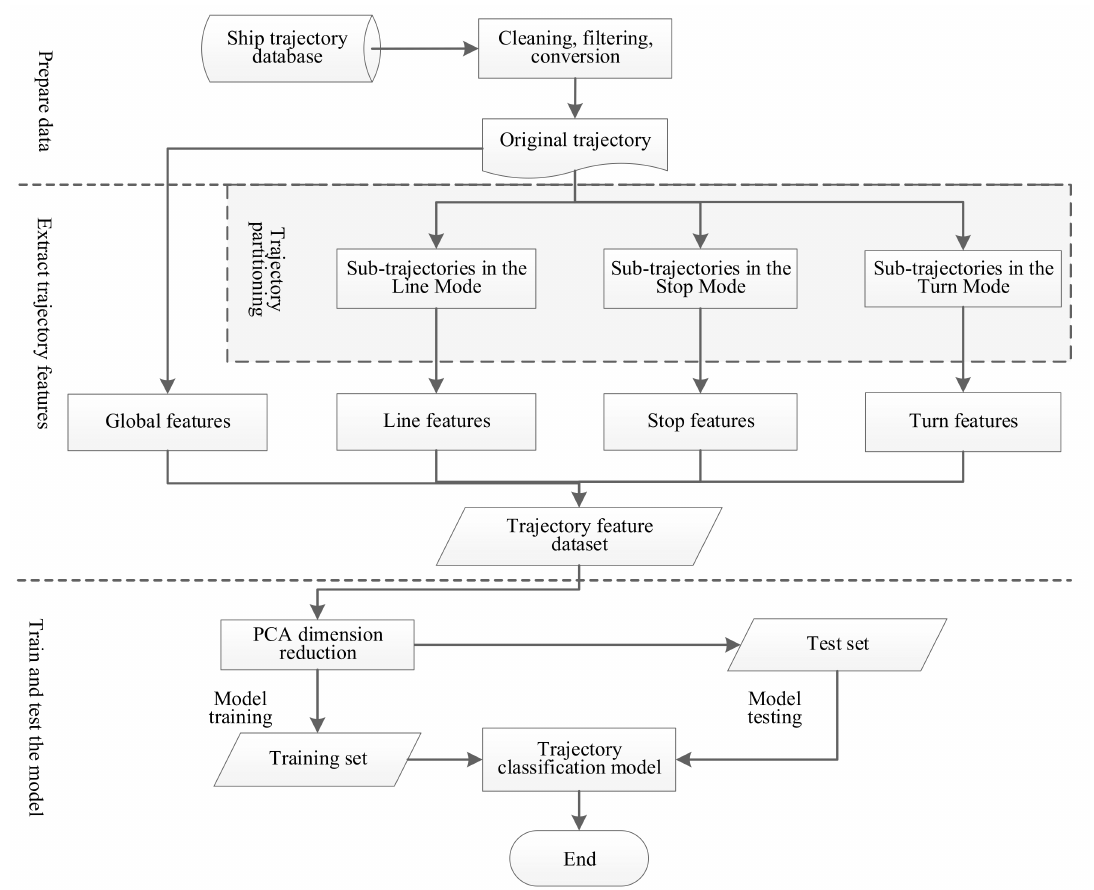
Figure 9. Overall framework of ship trajectory classification